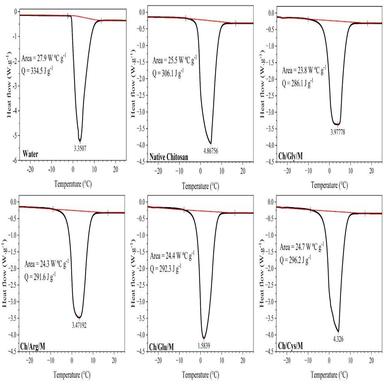
DSC thermograms of swollen hydrogels. The heat of fusion of freezing water in the hydrogel (Qendo (J/g)) for each sample are shown.